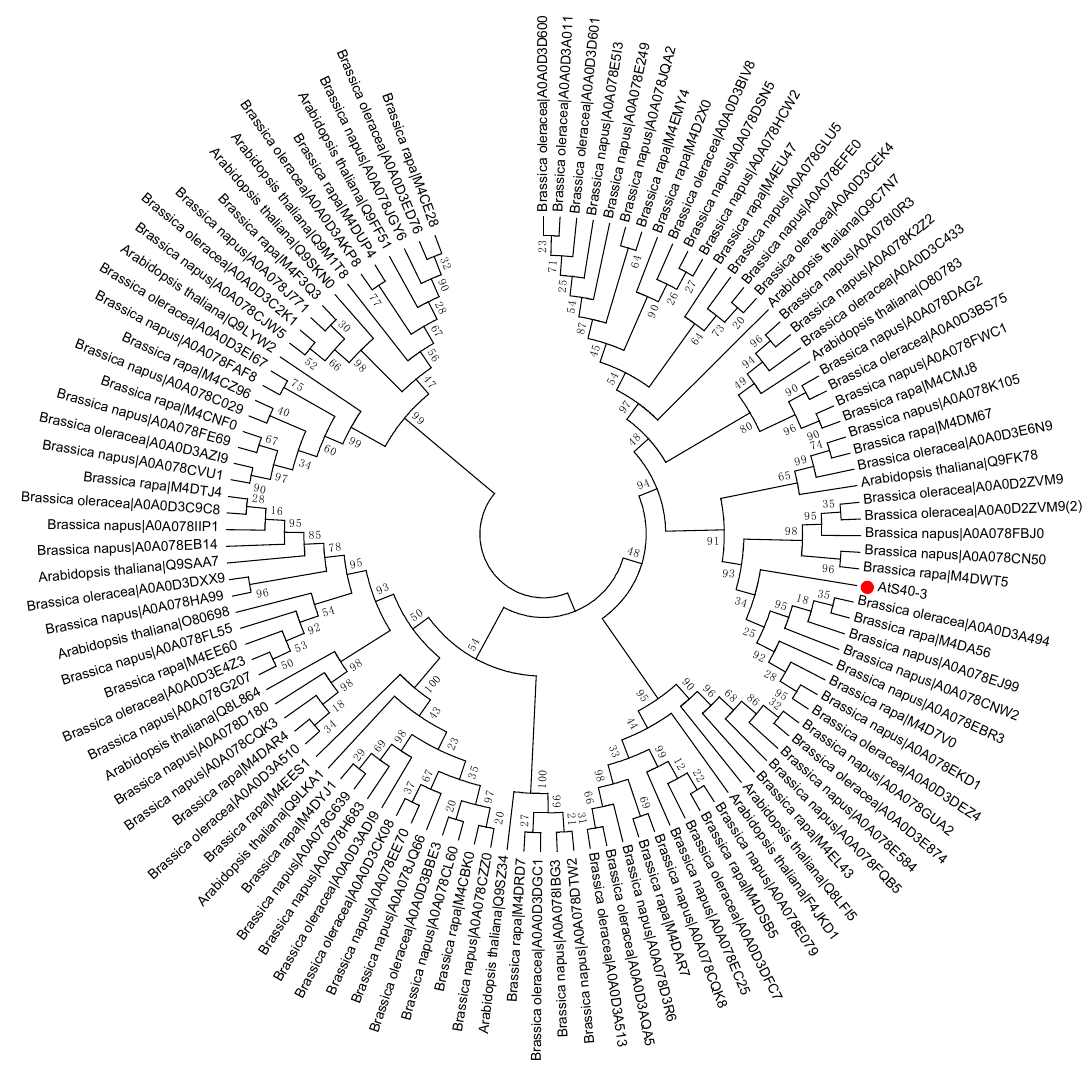
Figure 4. Phylogenetic tree of the S40 gene family in the sequenced genome Brassicaceae family including Arabidopsis thaliana , Brassica napus , Brassica oleracea , and Brassica rapa . Red dot indicates the S40 senescence reference gene, AtS40-3 . The MEGA 6.0 program was employed to construct a neighbor-joining phylogenetic tree using the JTT model with 1000 bootstrap replicates. The full-length amino acid sequences were aligned using Clustal Omega.